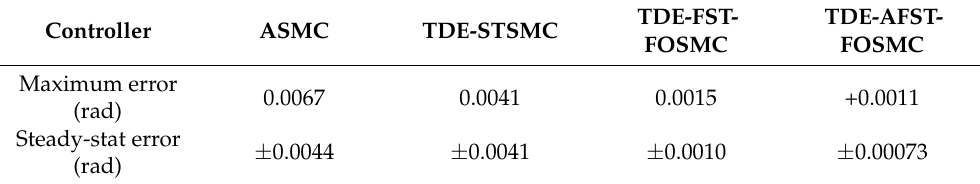
Table 3. Tracking errors comparison of different algorithms in slalom path